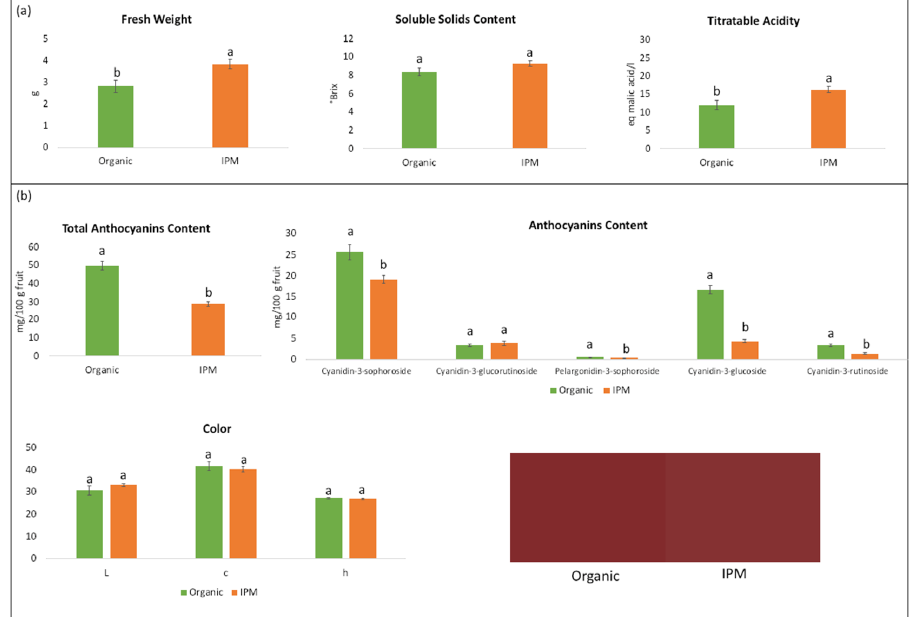
Figure 3. Main quality parameters ( a ), anthocyanidins content and color values ( b ) of raspberry fruit ‘Enrosadira’. Bars represent the mean ± SE. Different letters indicate significant differences between cultivation methods according to Student’s t -test at p -value < 0.05.